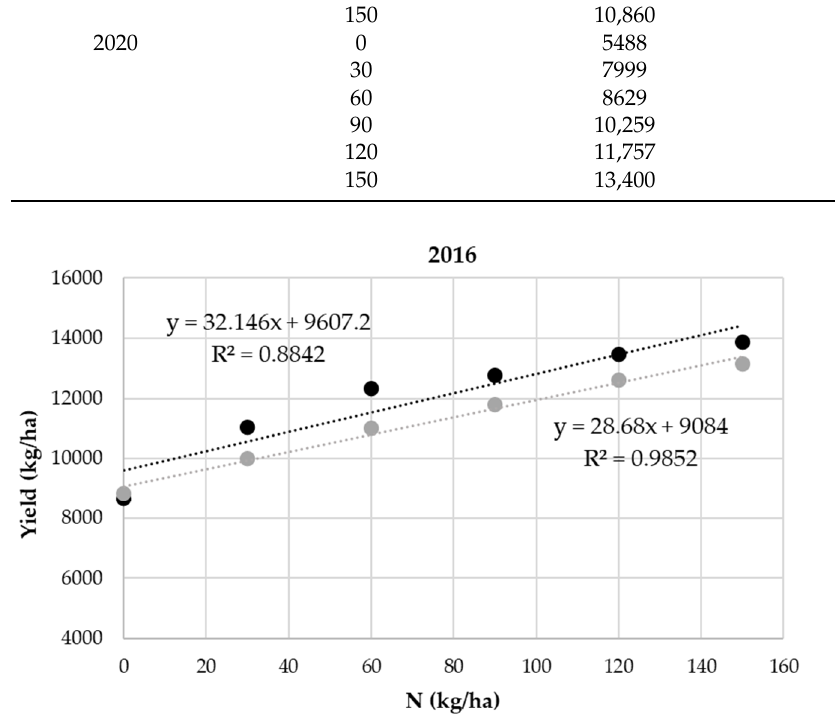
with R 2 = 0.98. One unit increase in nitrogen dose increased the yield by 32.14 kg/ha for the measured data, while it was 28.68 kg/ha for the simulated data (Figure 2).